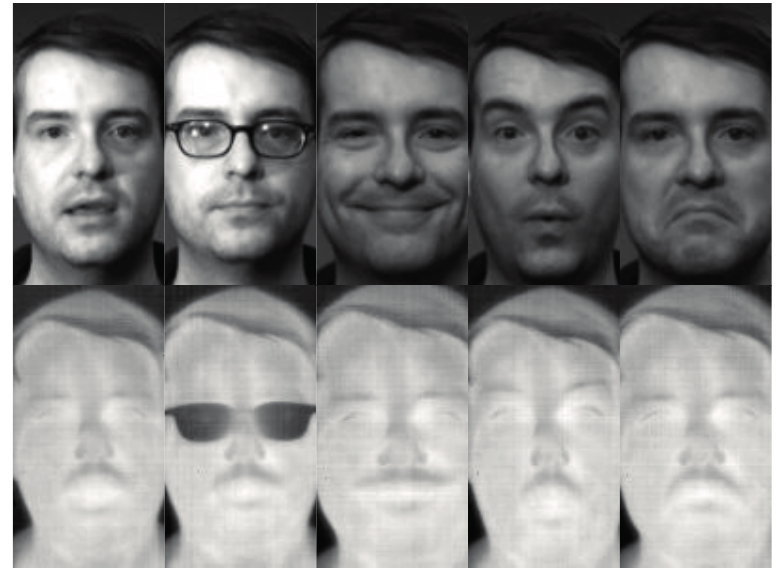
Figure 2. Equinox database